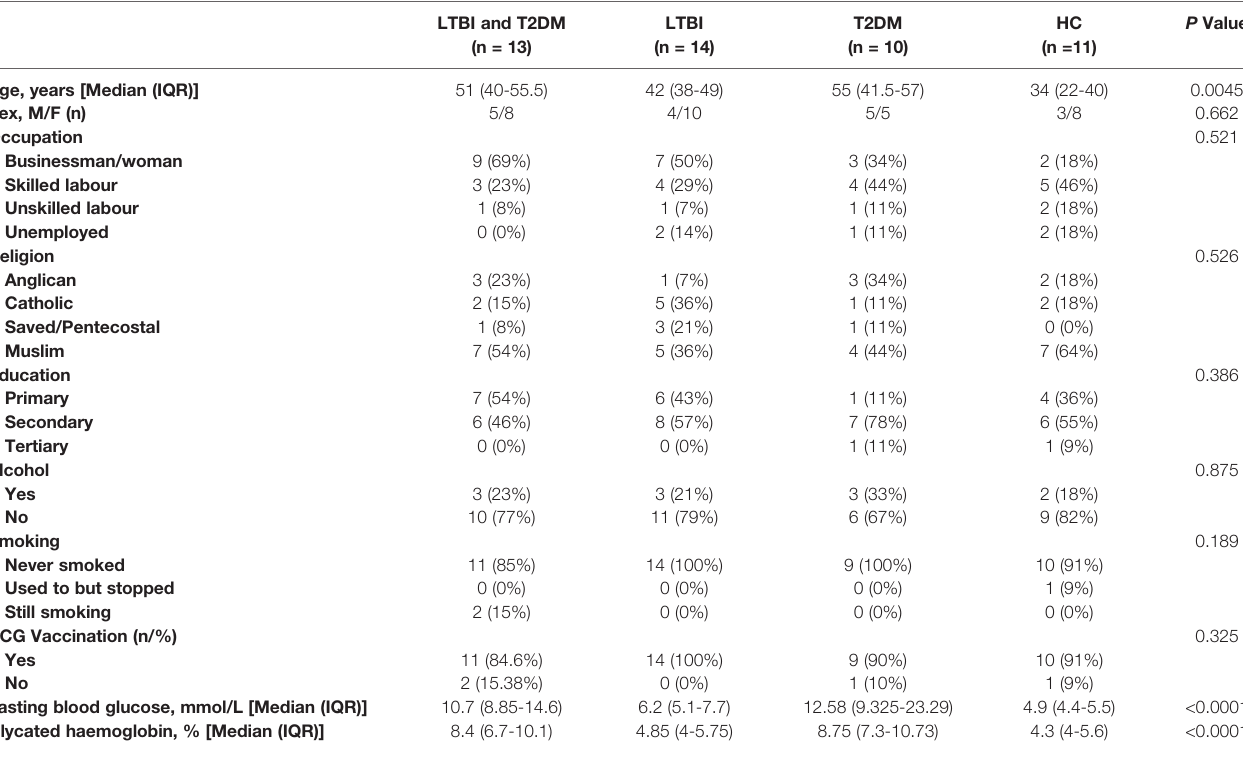
TABLE 1 | Characteristics of the study